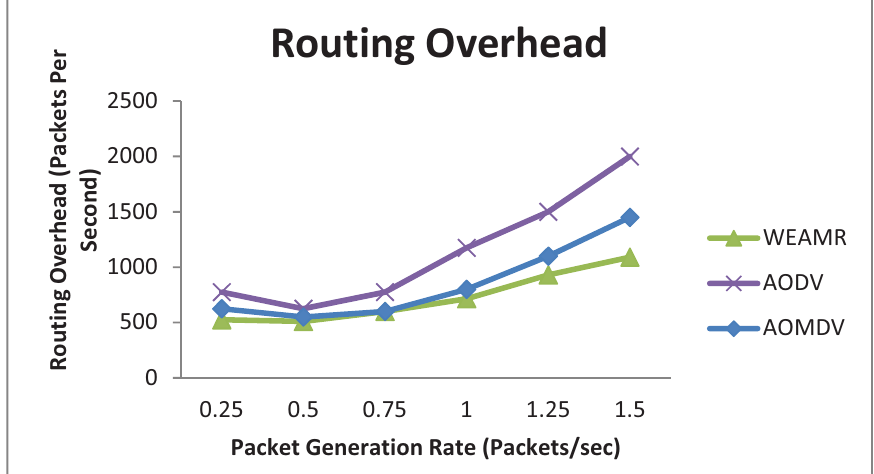
Figure 17. Average Routing overhead with increasing number of